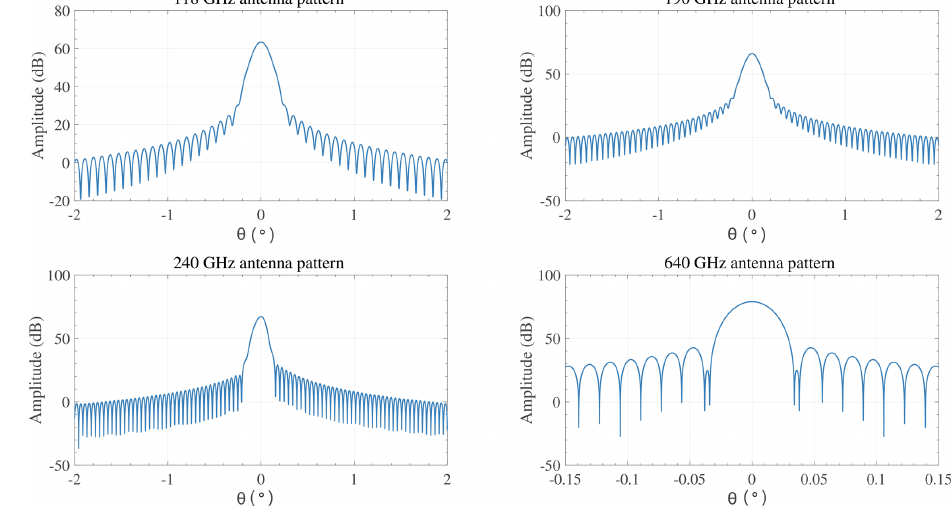
Figure 8. The antenna patterns of TALIS.